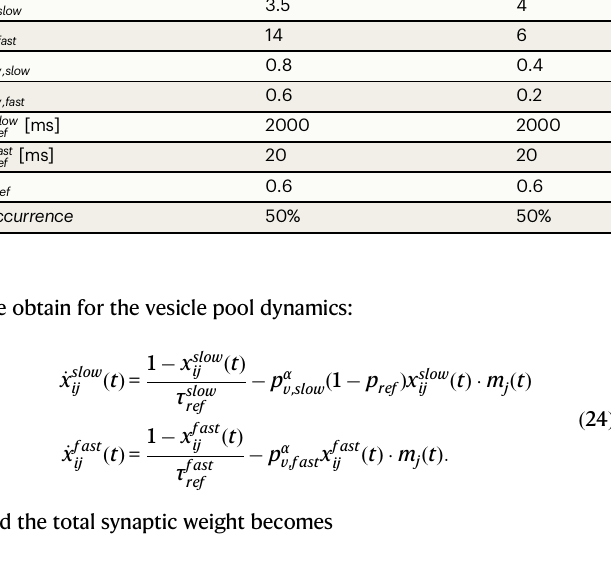
Table 3 | Synaptic parameters used in reduced model Drivers